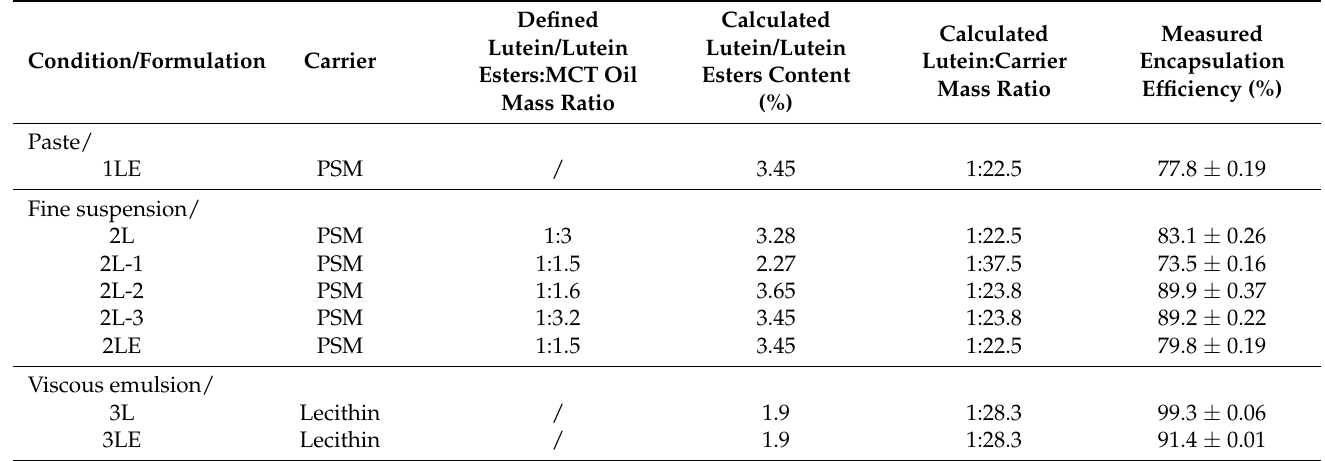
Table 2. Encapsulation efficiencies of the formulations with lutein/lutein esters.